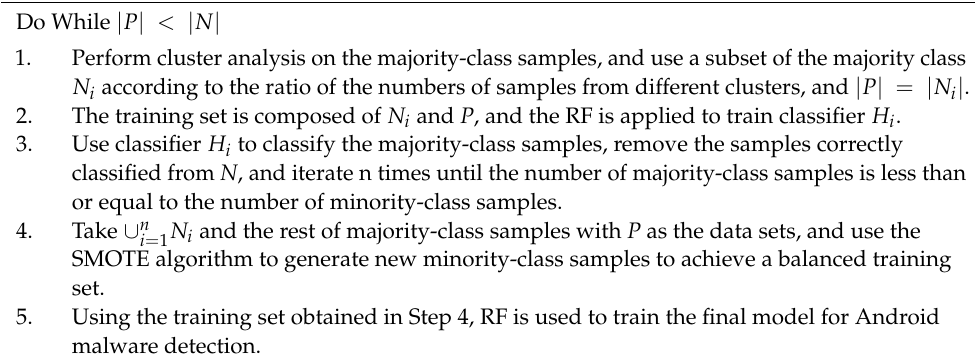
Algorithm 1 Given: Data set, where the minority-class samples are P , and the